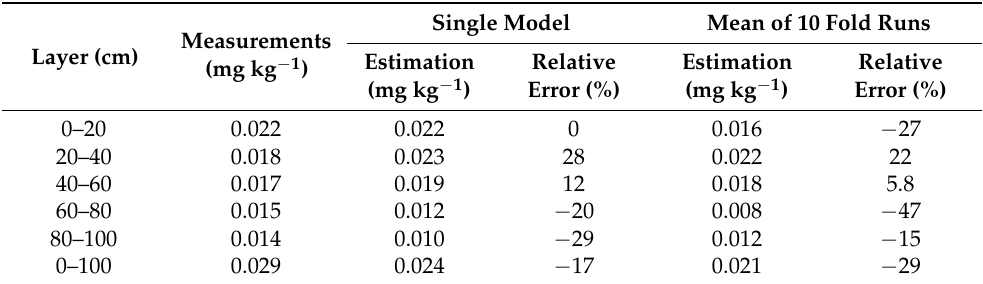
Table 7. Comparison of model predictions (single run of the selected model and the mean from 10 modeled maps) against field measurements of 64 verification